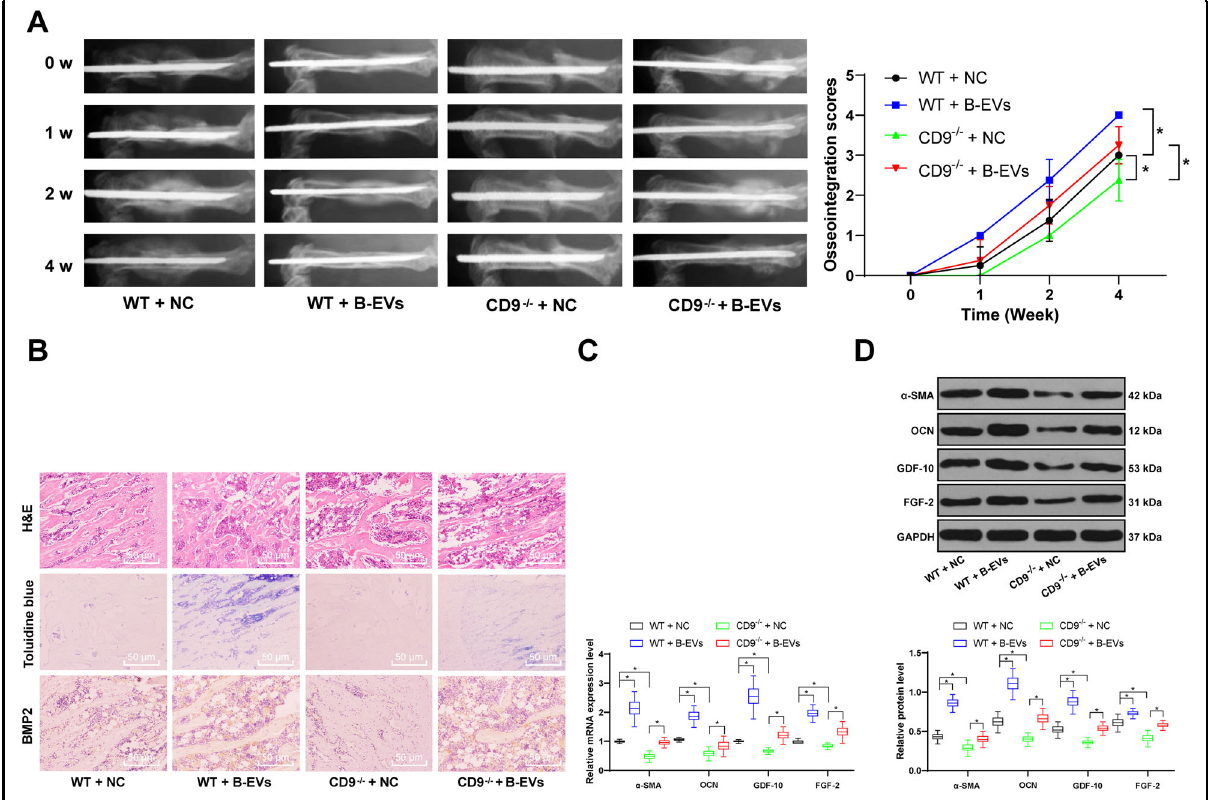
Fig. 1 B-EV treatment promotes bone fracture recovery. A Representative radiologic images of WT and CD9 − / − fracture mice after EV treatment at 0, 1, 2, and 4 weeks after EV treatment. The femurs of WT mice and CD9 − / − mice were harvested 2 weeks after fracture. B HE staining, toluidine blue staining, immunochemistry of BMP2 were performed to access bone fracture healing. C RT-qPCR, and D western blot analysis were performed to determine mRNA and protein levels of α -SMA, OCN, GDF-10, and FGF-2. Data are expressed as mean ± standard deviation. Two-way ANOVA and Tukey ’ s multiple comparisons test were used to determine statistical signi fi cance. * p < 0.05. n = 8 in each